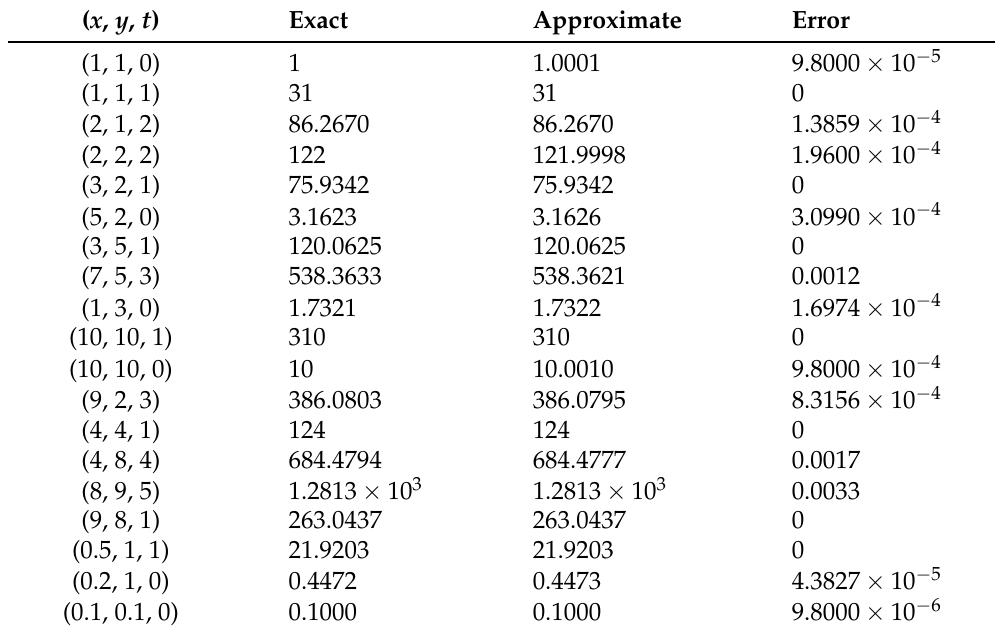
Table 1. Comparison table between the exact [15] and the approximate series solution Equation (10).